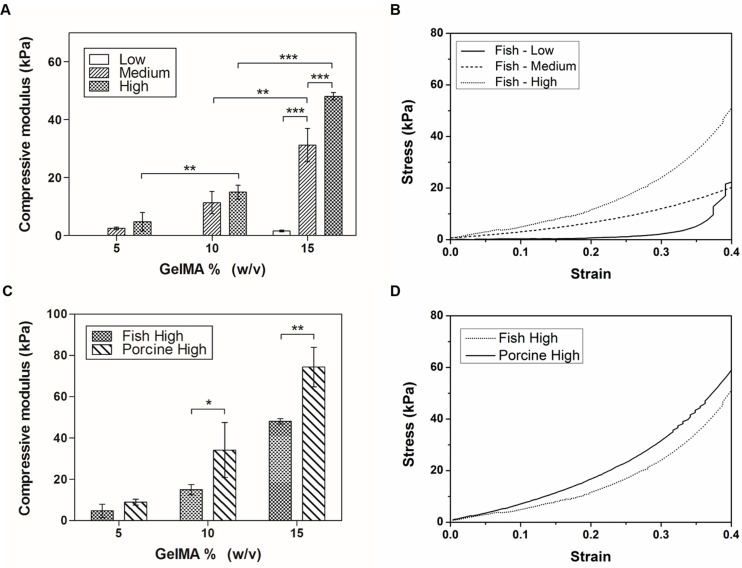
Mechanical properties of fish GelMA hydrogels with various degrees of methacrylation and gel percentages.(A) Compressive modulus for 5%, 10% and 15% (w/v) fish GelMA at low, medium and high degree of methacrylation, with the exception of low degree, 5% and 10% (w/v) GelMA which formed gels too weak to be handled for testing. (B) Representative stress-strain curve of a 15% (w/v) GelMA according to degree of methacrylation. (C) Comparison of fish and porcine GelMA hydrogels with a high degree of methacrylation. (D) Representative curve of 15% (w/v) GelMA for fish and porcine GelMA comparison. Conditions of 10% and 15% (w/v) GelMA were significantly different (*p<0.05, **p<0.01, ***p<0.001). Error bars represent SDs of measurements performed on 3 samples.